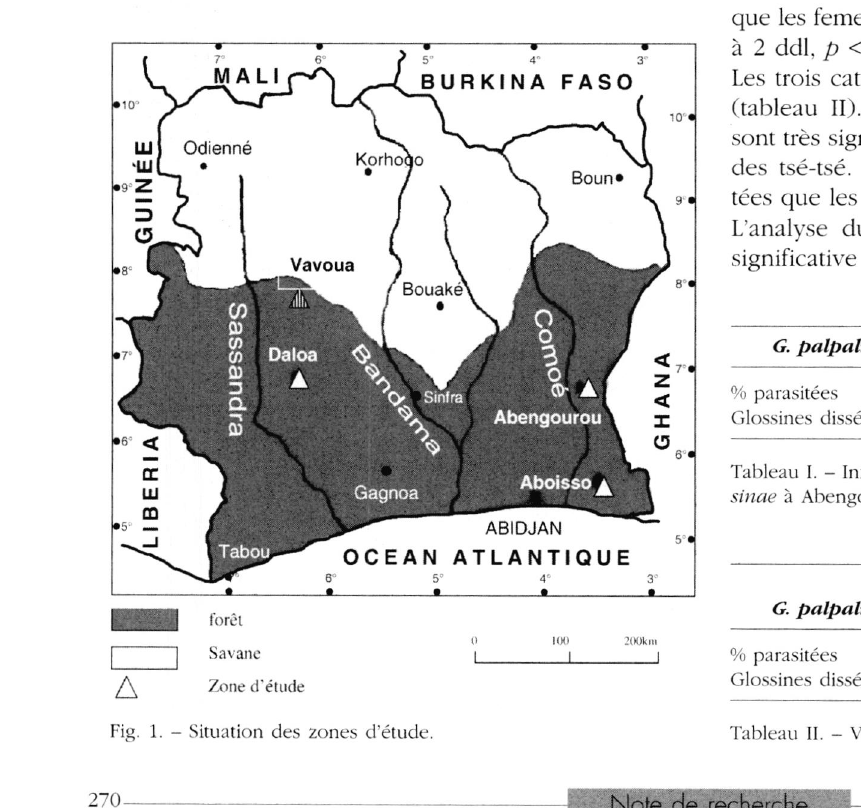
Fig. 1. - Situation des zones d'étude.